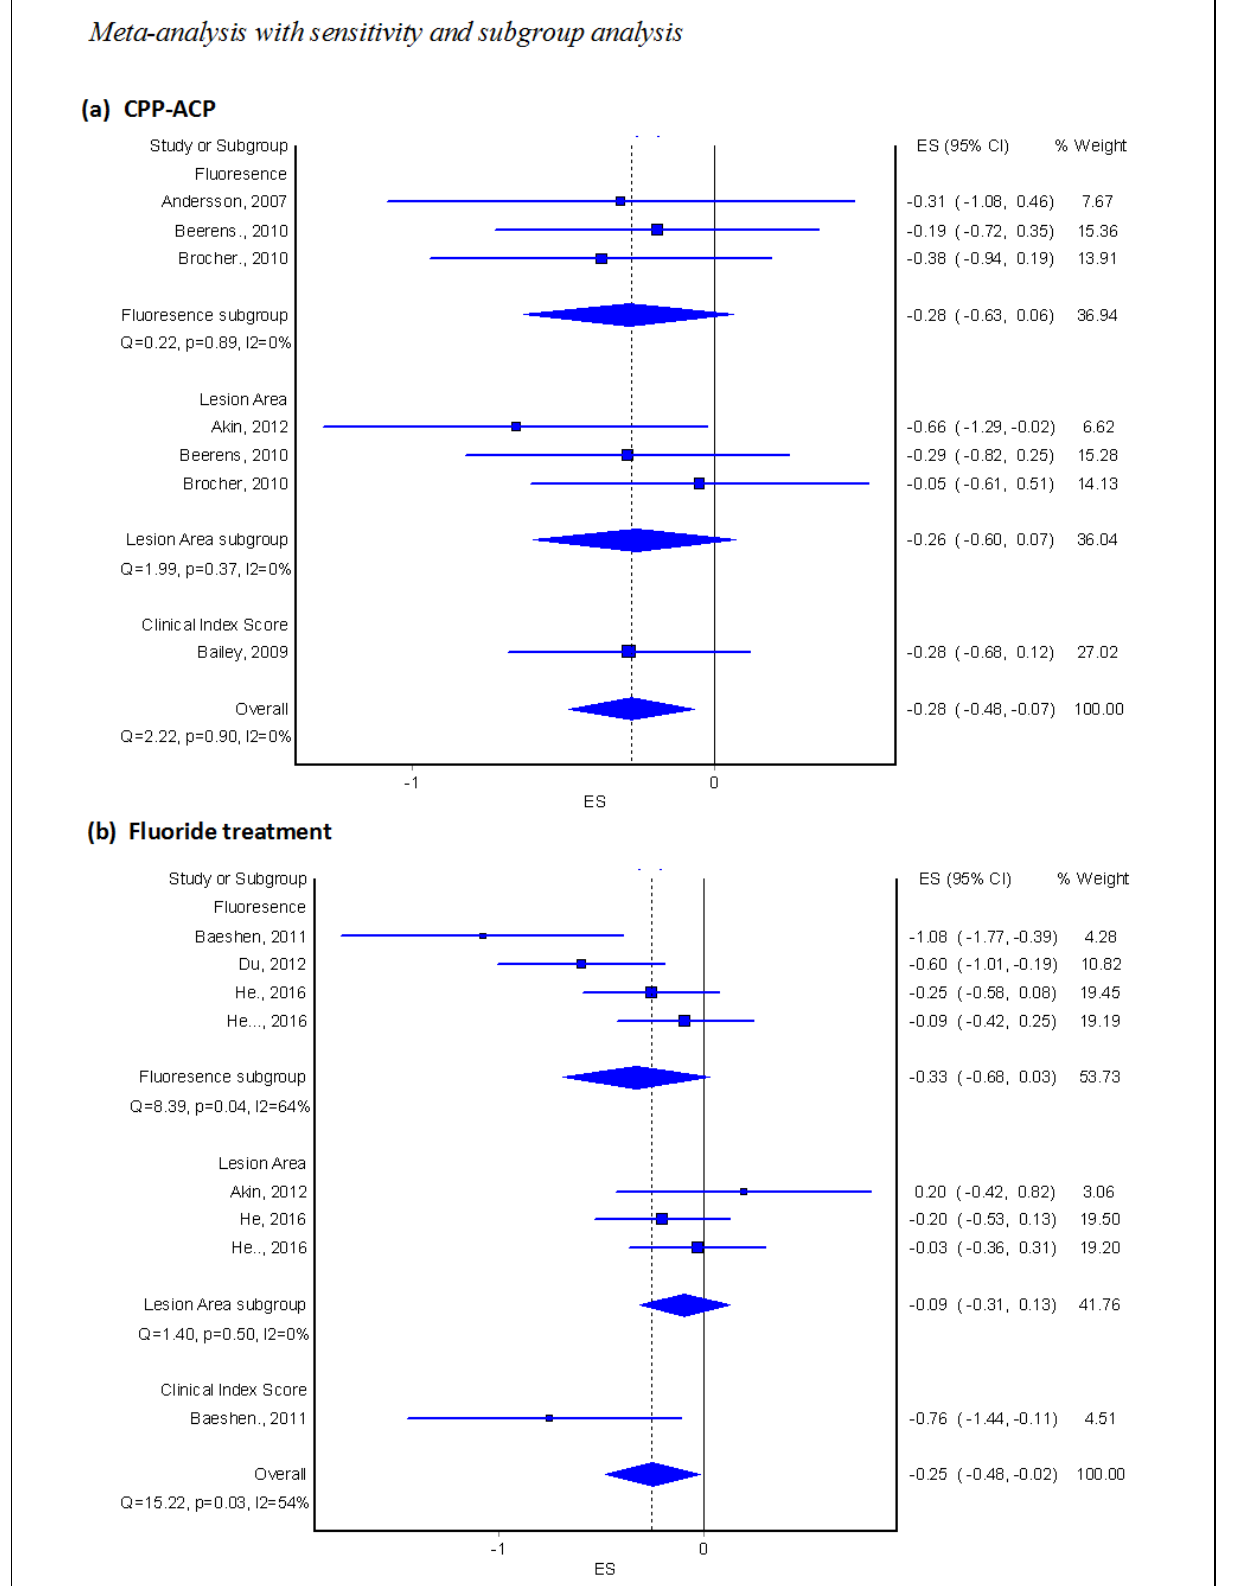
Figure 2. Pooled d : Effectiveness of CPP-ACP and fluoride treatment in reducing WSL outcomes using quality-effects